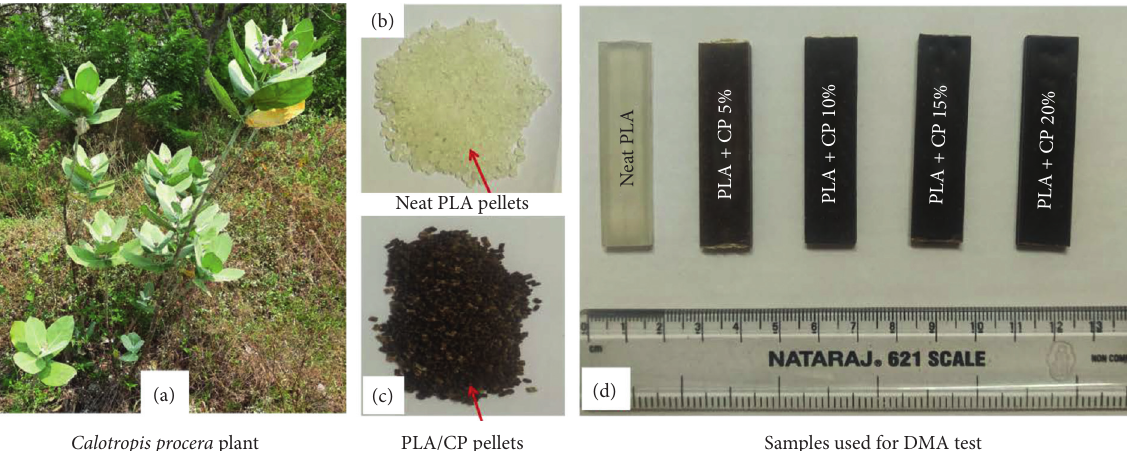
Figure 1: (a) Calotropis procera plant. (b) Neat PLA pellets. (c) PLA/CP pellets. (d) Samples used for DMA